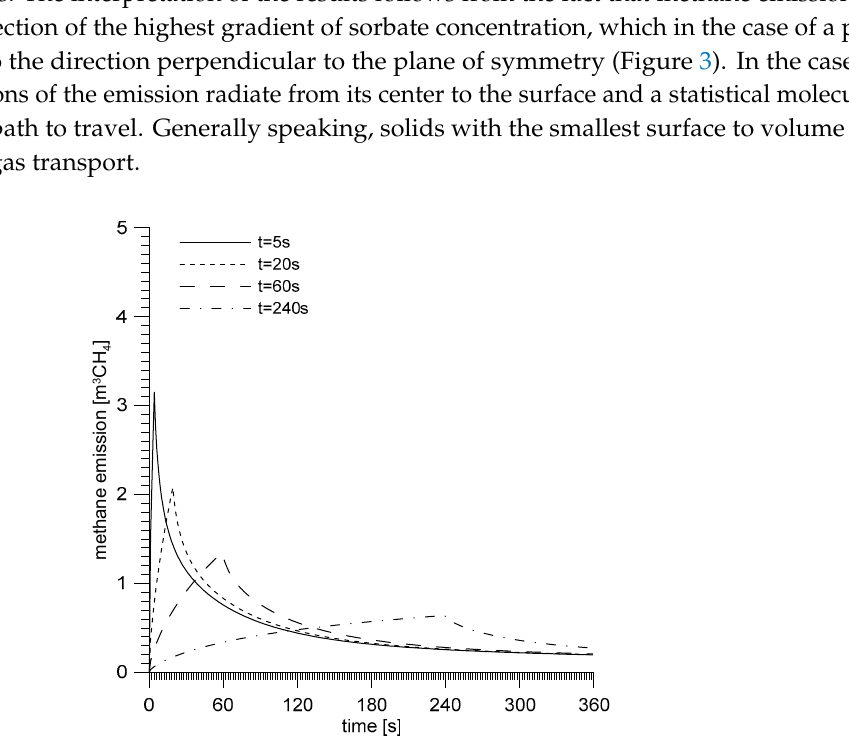
Figure 18. Model methane emission based on the plane sheet model during Zofiówka outburst.